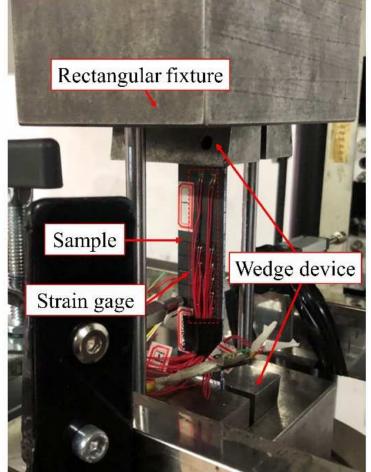
Figure 3. Test set-up for compressive